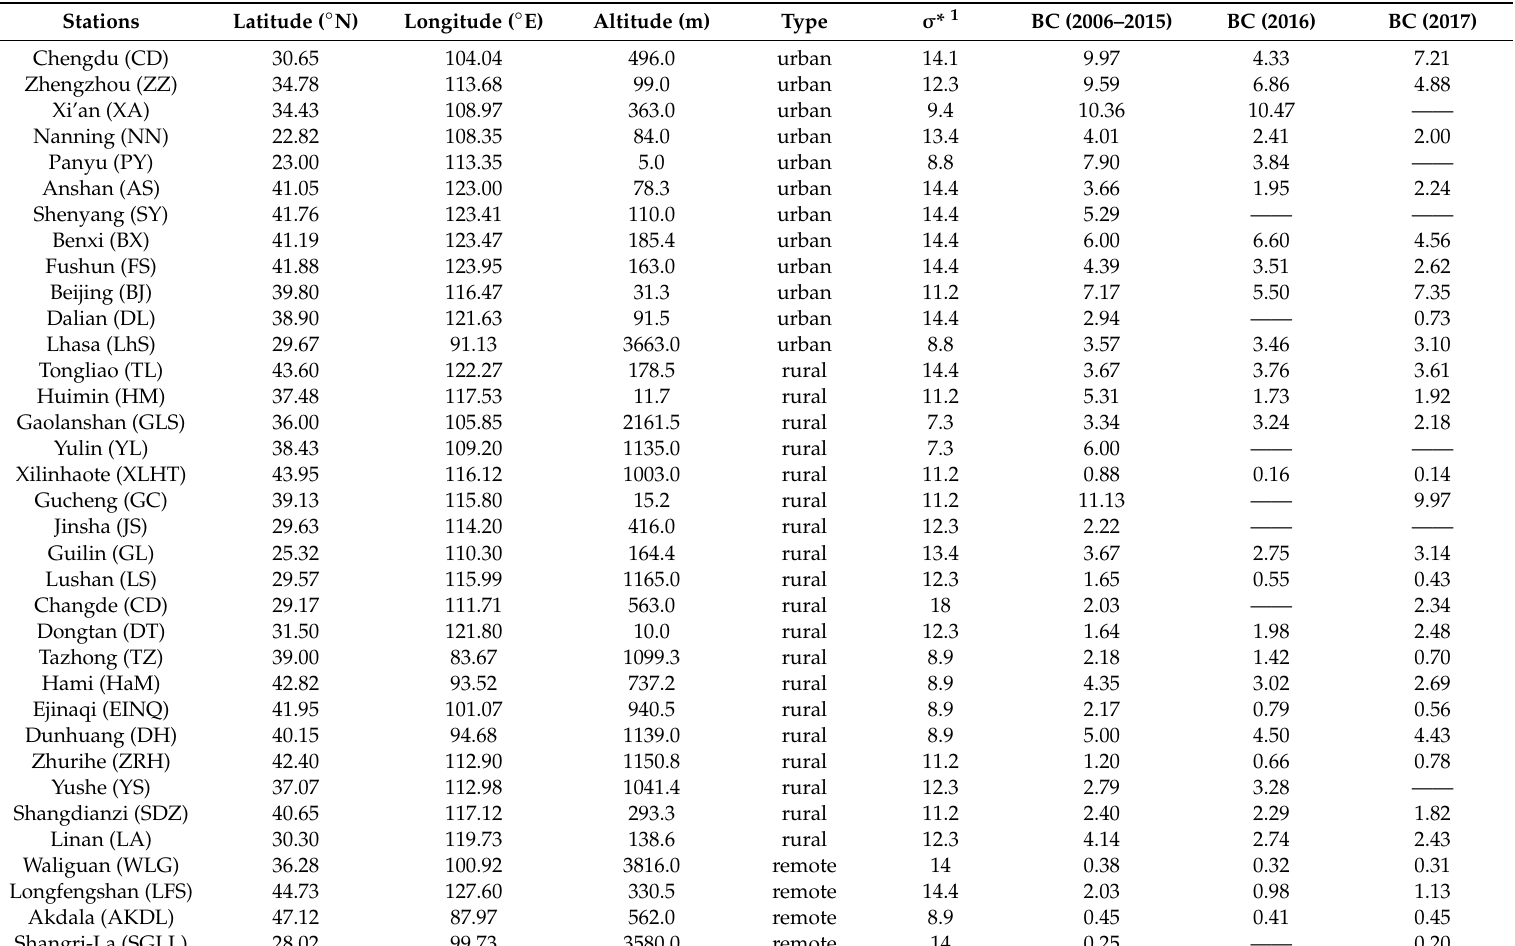
Table 1. Location, grade, absorption cross section and average black carbon (BC) concentration of each